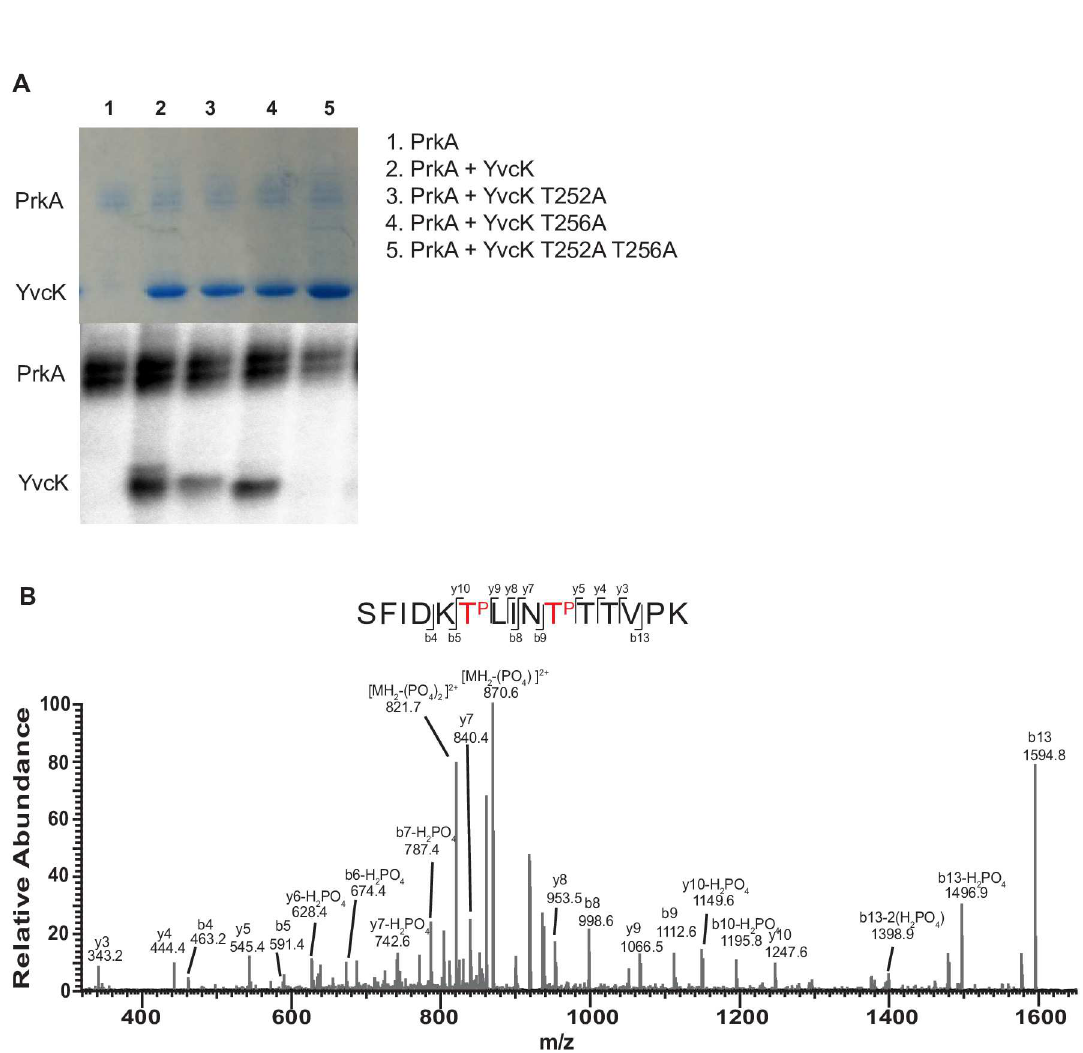
Fig 4. PrkA phosphorylates YvcK on 2 independent threonines. (A) PrkA was incubatedwith [ γ - 32 P]ATP separately (lane 1), with YvcK (lane 2) or with YvcK point mutants (lanes 3–5) overnight, proteins were separated by SDS-PAGE and analyzedeither by coomasie to demonstrate equivalentamounts of YvcK in each reaction (Top) or autoradiography (Bottom). (B) MS/MS of phosphorylated YvcK identifiedthe doublycharged ion 693.34 m/z (monoisotopic mass 1384.67 Da) matched to a doubly phosphorylated YvcK 247–261tryptic peptide with one missed cleavagesite. Phosphorylated threonines (red) 252 and 256 can be identifieddefinitively by either b or y